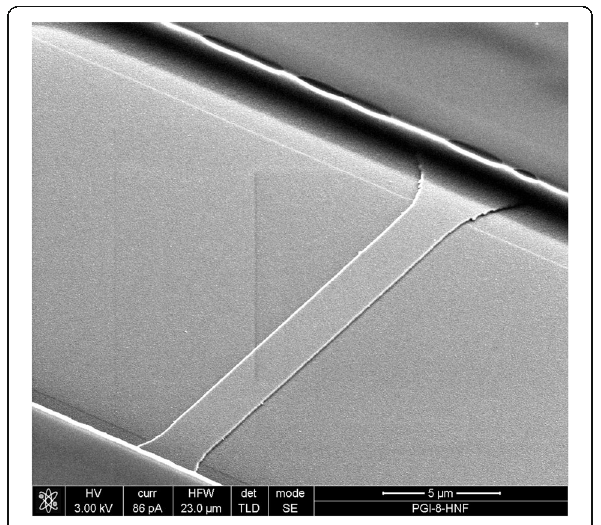
Fig. 2 SEM image of Si NW FET structure. Typical scanning electron micrograph (SEM) image of fabricated Si nanoribbon field-effect transistor structure